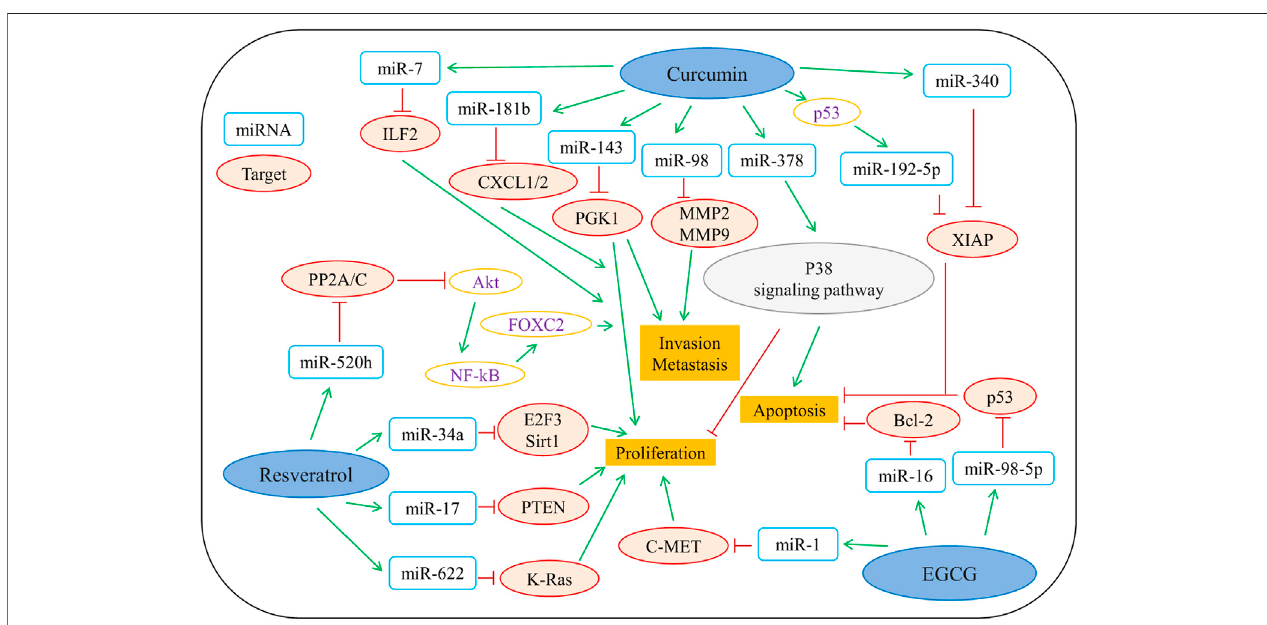
FIGURE 6 | Representative polyphenols that are involved in regulating the antitumor mechanisms of microRNAs. MiR, microRNA; ILF2, Interleukin enhancer binding factor 2; CXCL1/2, chemokine (C-X-C motif) ligands 1/2; PGK1, phosphoglycerate kinase 1; MMP2/9, matrix metalloproteinase 2/9; XIAP, X-linked inhibitor of apoptosis; PP2A/C, protein phosphatase 2A/C; E2F3, E2F transcription factor 3; Sirt1, Sirtuin type 1; PTEN, phosphatase and tensin homolog; K-Ras, kirsten rat sarcoma; C-MET, cellular-mesenchymal epithelial transition factor; Bcl-2, B-cell lymphoma-2; p53, protein 53; P38 signaling pathway, protein 38 signaling pathway. reproduced with copyright permission from Elsevier (Yi et al., 2019).